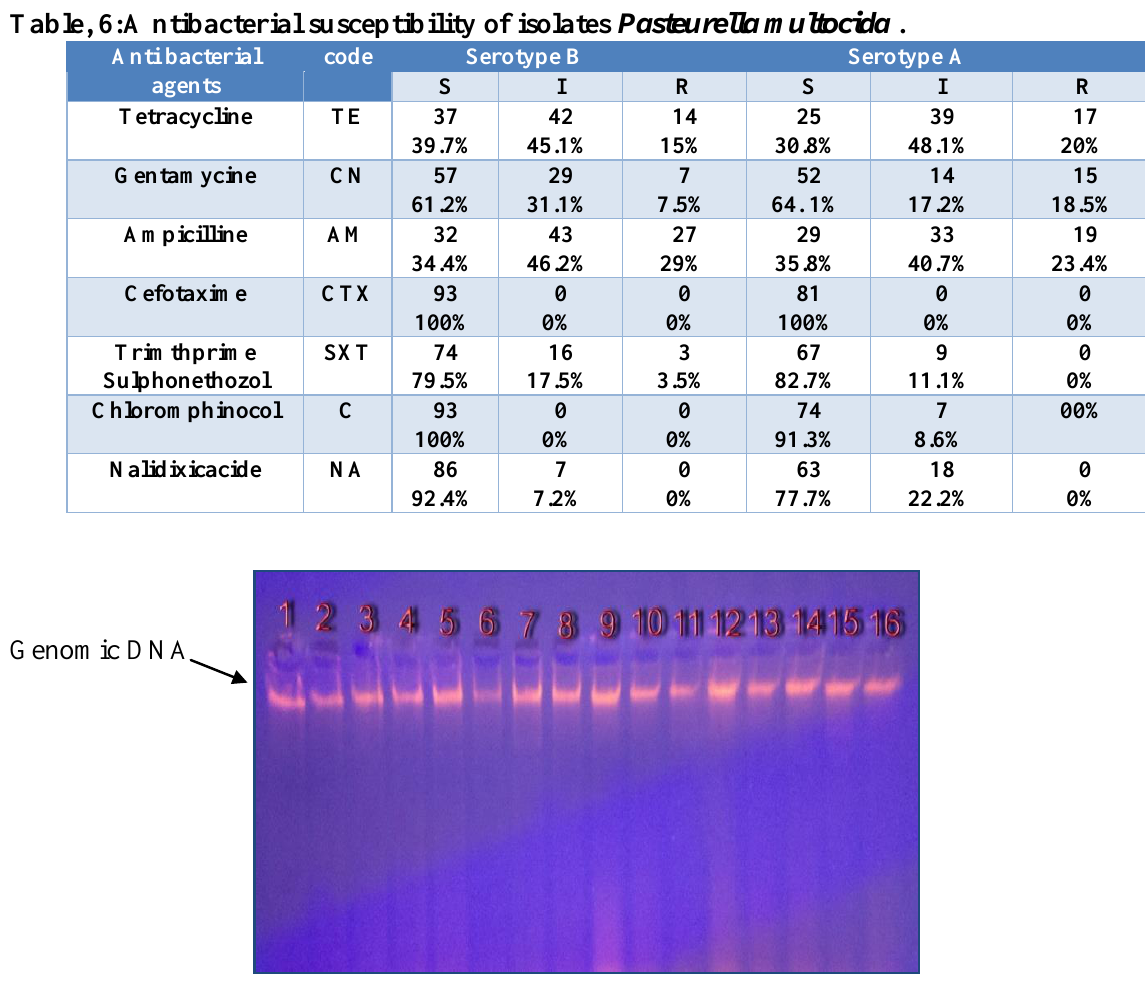
Figure, 1: Shows Genomic DNA of pasteurella multocida (1-16) positive isolate which isolates from cattle and buffalo as appear in agarose 2% by using electrophoresis in PCR